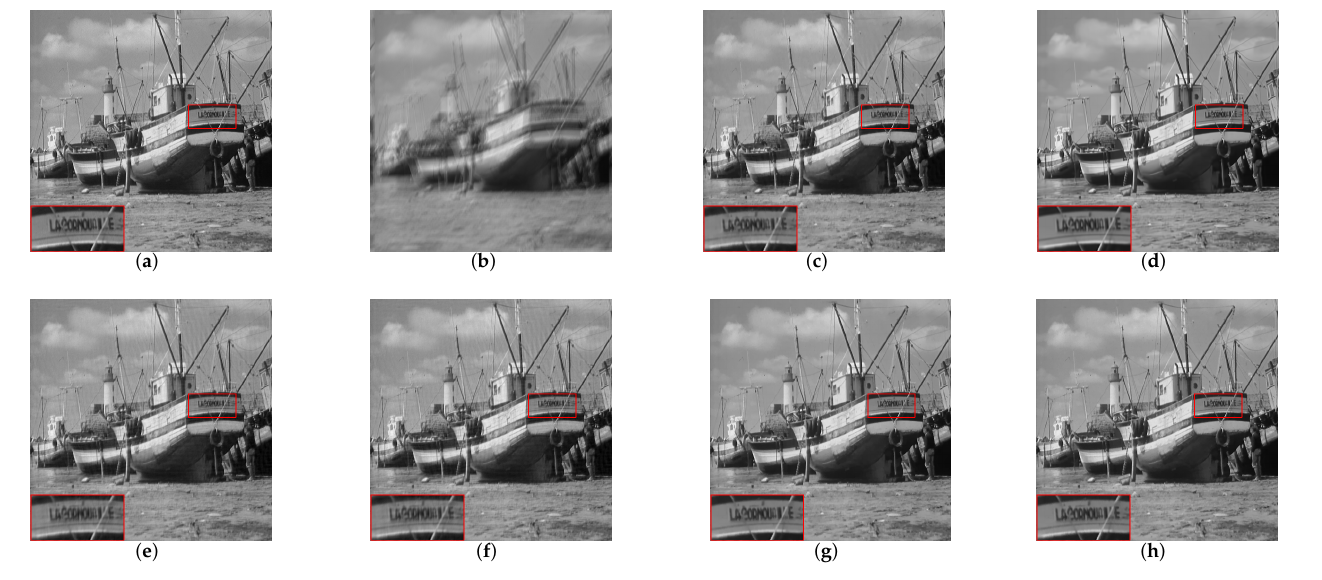
Figure 3. Recovered results results of image ( f ) obtained using different algorithms. ( a ) Original. ( b ) Degraded. ( c ) TwIST. ( d ) IDBP. ( e ) D-ADMM (a). ( f ) D-ADMM (i). ( g ) H + TV (a). ( h ) H + TV (i).